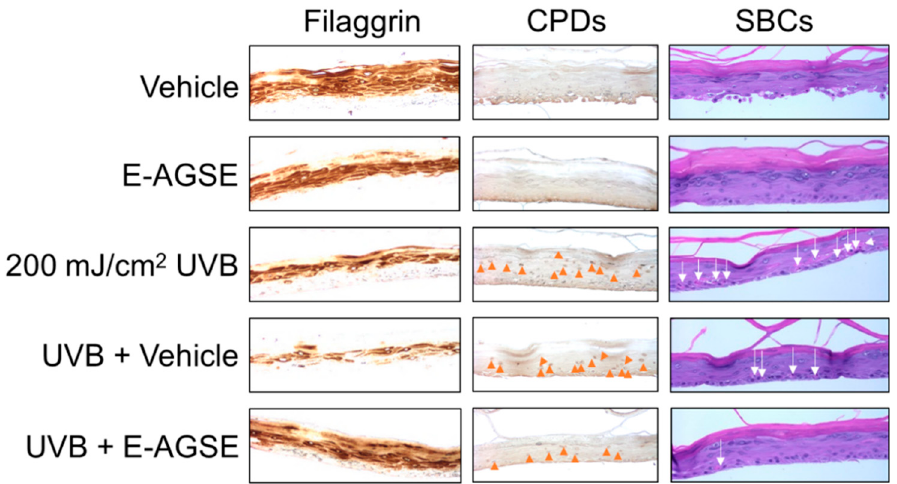
Figure 3. E-AGSE increases skin barrier components and protects from DNA damage after UVB irradiation. EpiDerm™ 3D skin culture models were topically pretreated with E-AGSE (0.1%) for 4 h, then irradiated with 200 mJ/cm 2 UVB and later incubated for 24 h with actives. Tissues were fixed in 10% formalin, paraffin embedded, and mounted on slides. Immunohistochemical staining (DAB) for filaggrin. Immunohistochemical staining (DAB) for CPDs and H&E staining for SBCs. Blue and white arrowheads indicate positive CPD and sunburn cells, respectively. Original magnification: ×